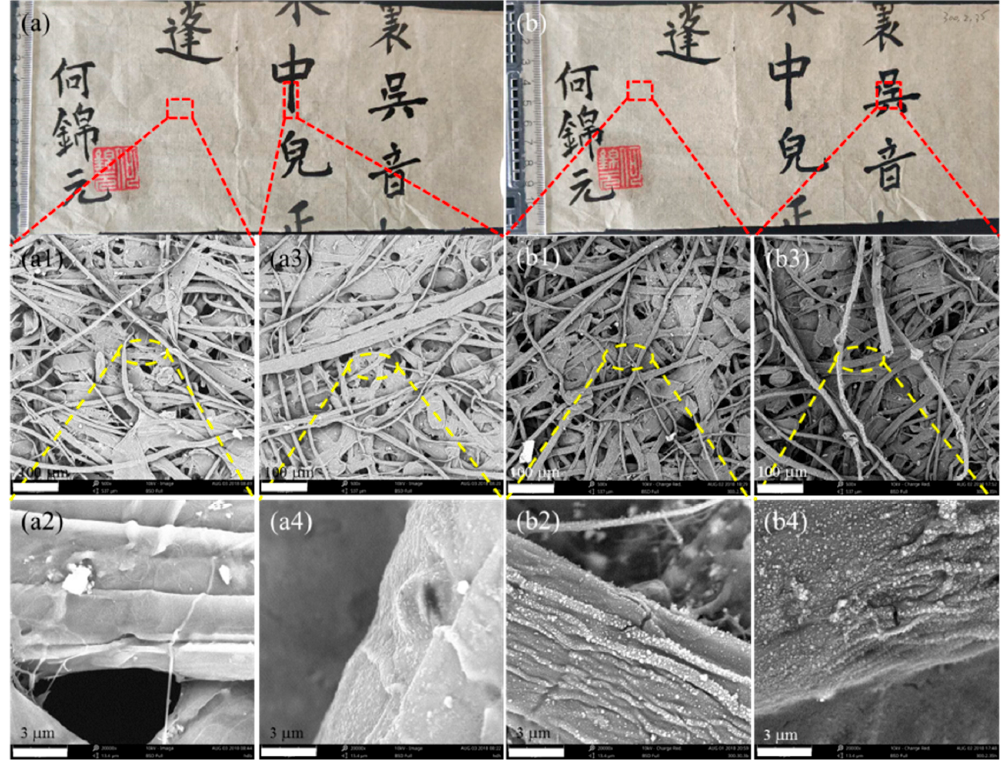
Figure 3. The macro and micro SEM images of the paper relics before ( a – a4 ) and after ( b – b4 ) plasma treatment (300 V, 30 g/h, two repeat treatments) at blank and inked sites, respectively. treatment (300 V, 30 g / h, two repeat treatments) at blank and inked sites,